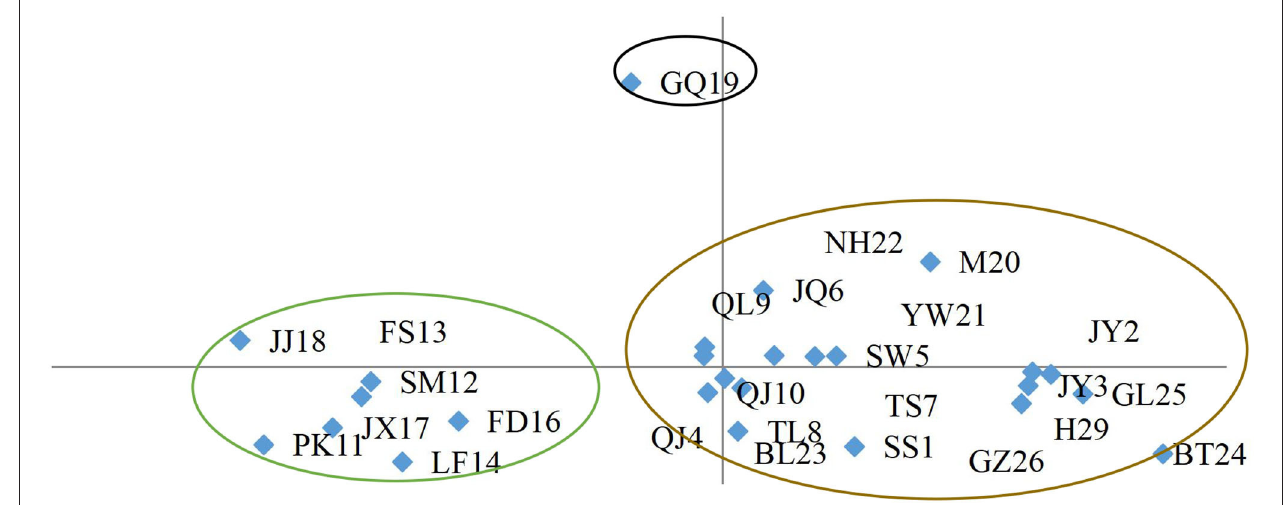
FIGURE 2 | PCA grouping C. paliurus populations based on ISSR and SSR marker data.